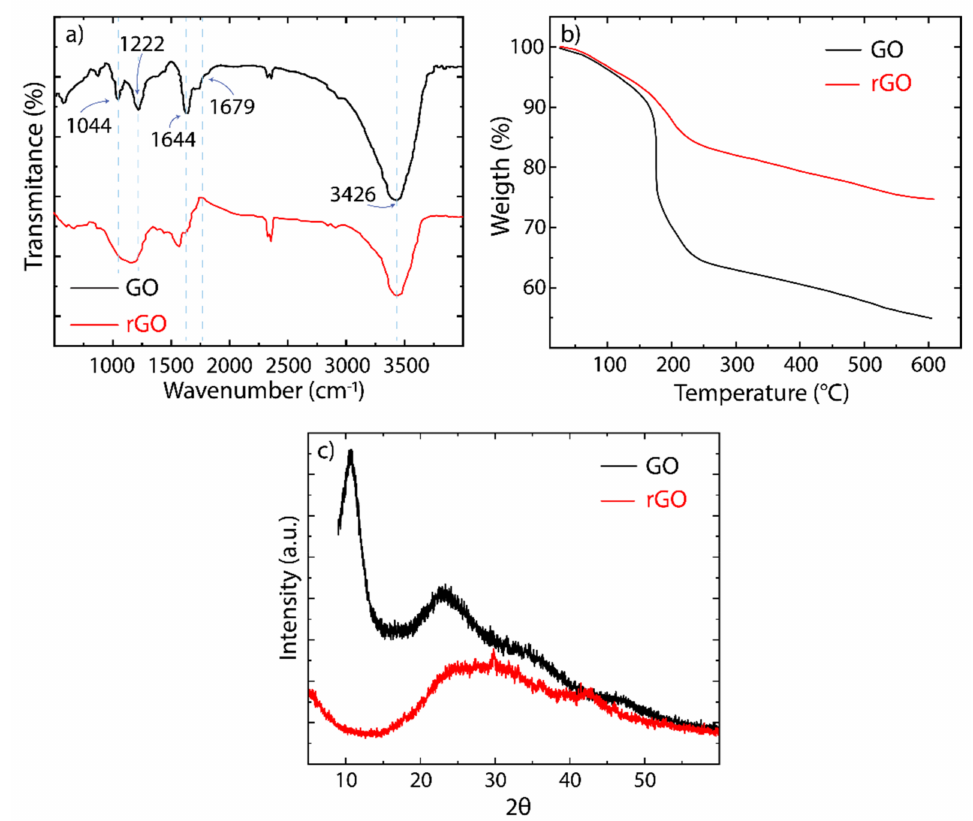
Figure 4. ( a ) Infrared spectra, ( b ) thermogravimetric study, and ( c ) XRD patterns of GO (black) and rGO (red),